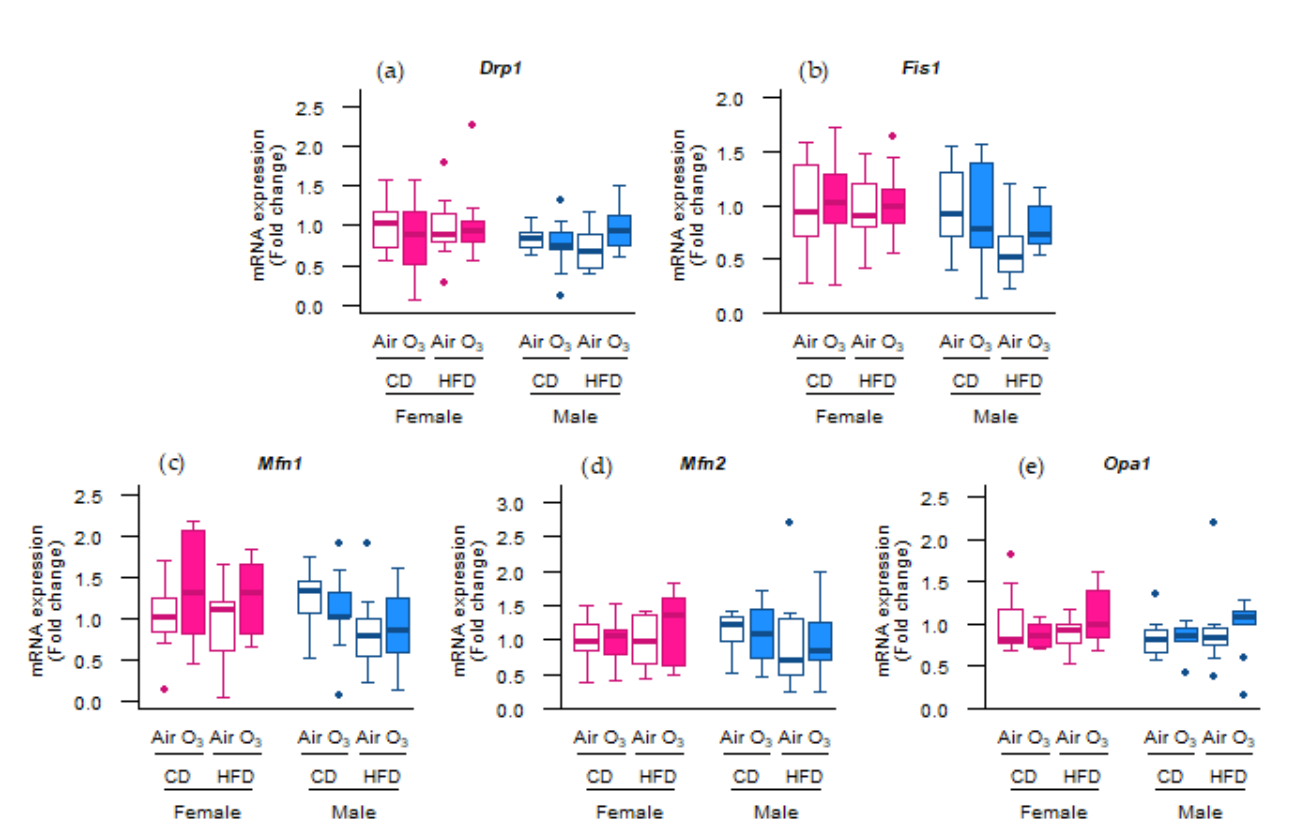
Figure 6. Acute ozone exposure and perinatal high-fat diet (HFD) did not alter the pulmonary molecular regulation of mitochondrial fission or fusion. Expression of fission genes ( a ) Drp1 and ( b ) Fis1 , and fusion genes ( c ) Mfn1 , ( d ) Mfn2 , and ( e ) Opa1 was measured within two hours after exposure to filtered air or ozone in the lungs of female and male offspring from dams fed a perinatal control diet (CD) or HFD. Data are presented as boxplots. Statistical analysis by two-way ANOVA with a Holm–Sidak post-hoc test. n = 9–10 per group. O 3